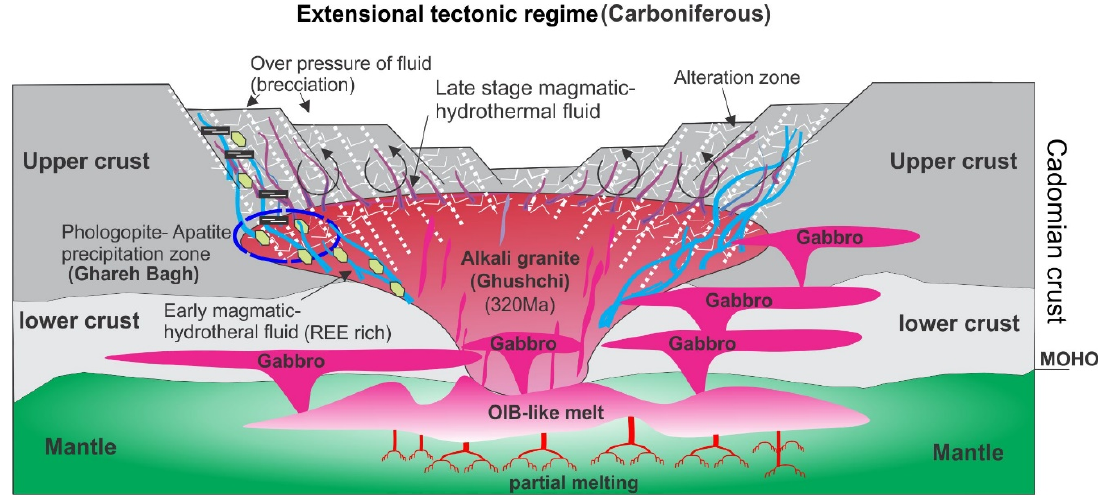
Figure 11. A conceptual genetic model of phlogopite and apatite formation in the Ghareh Bagh mica mine with breccia, alteration and tectono-genetic relations with Ghushchi alkaline magma and gabbronorite based on apatite